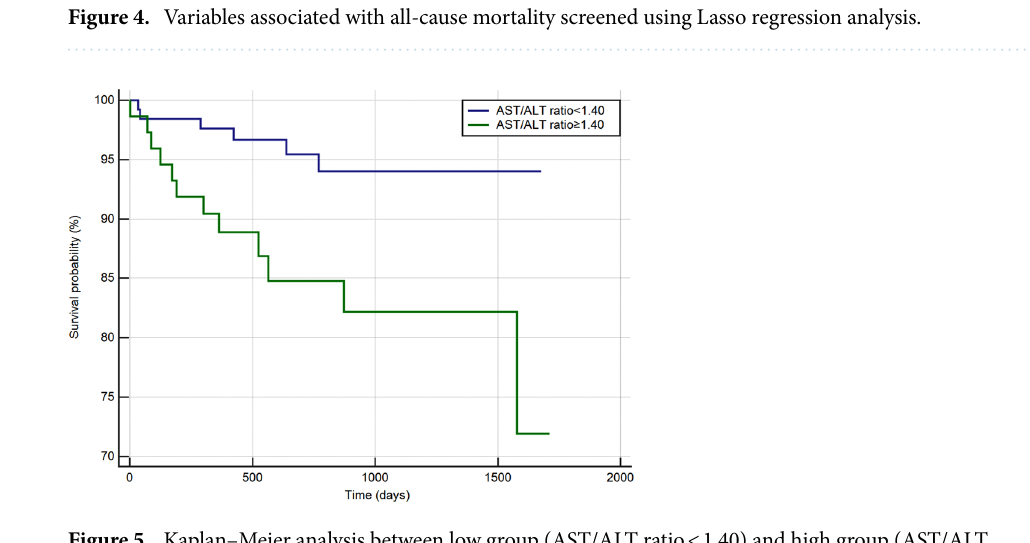
Figure 5. Kaplan–Meier analysis between low group (AST/ALT ratio < 1.40) and high group (AST/ALT ratio ≥